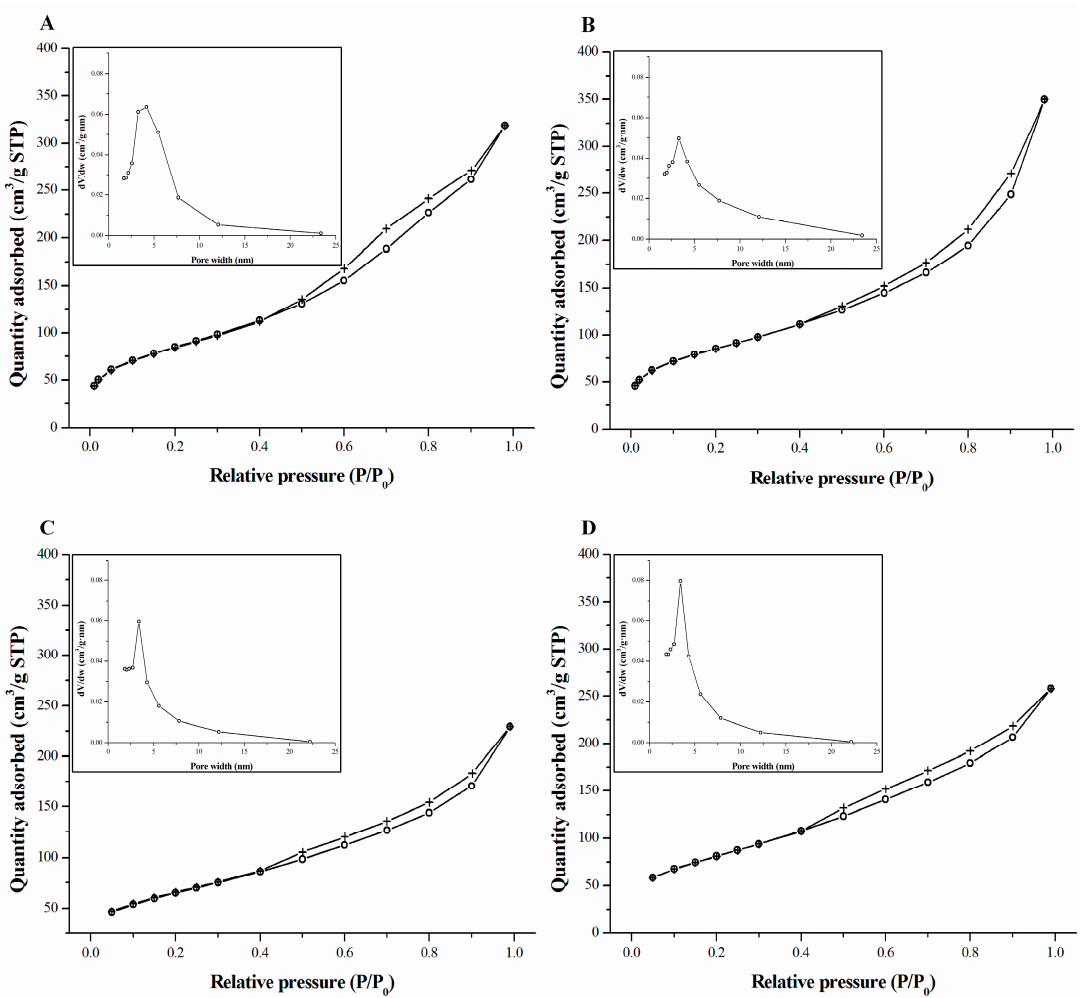
Figure 2. Nitrogen adsorption-desorption isotherms for silica powders obtained from: ( A ) horsetail, ( B ) common reed, ( C ) rye straw, and ( D ) wheat straw. The adsorption and desorption curves are presented with open circles and crosses, respectively. The insets show the pore size distribution of the studied powders.